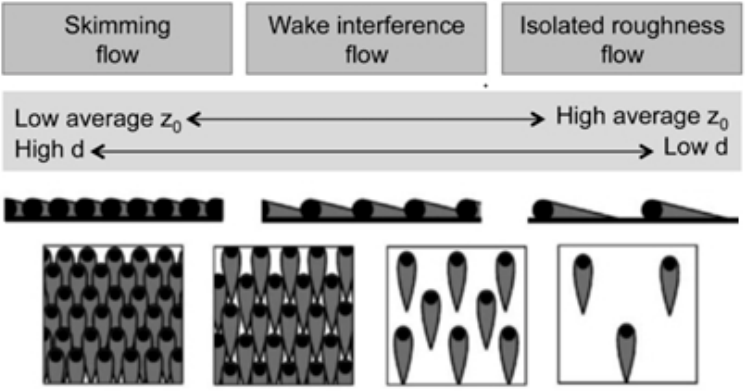
Figure 2. Flow regimes and associated theoretical wake development, shown in schematic plan and side view. Shaded areas are wake regions. The effect of different flow regimes on average z o (aerodynamic roughness) and d (displacement height) per plant unit is shown. (Modified and reproduced from Mayaud et al. [4], p. 142 under the Creative Commons attribution license).